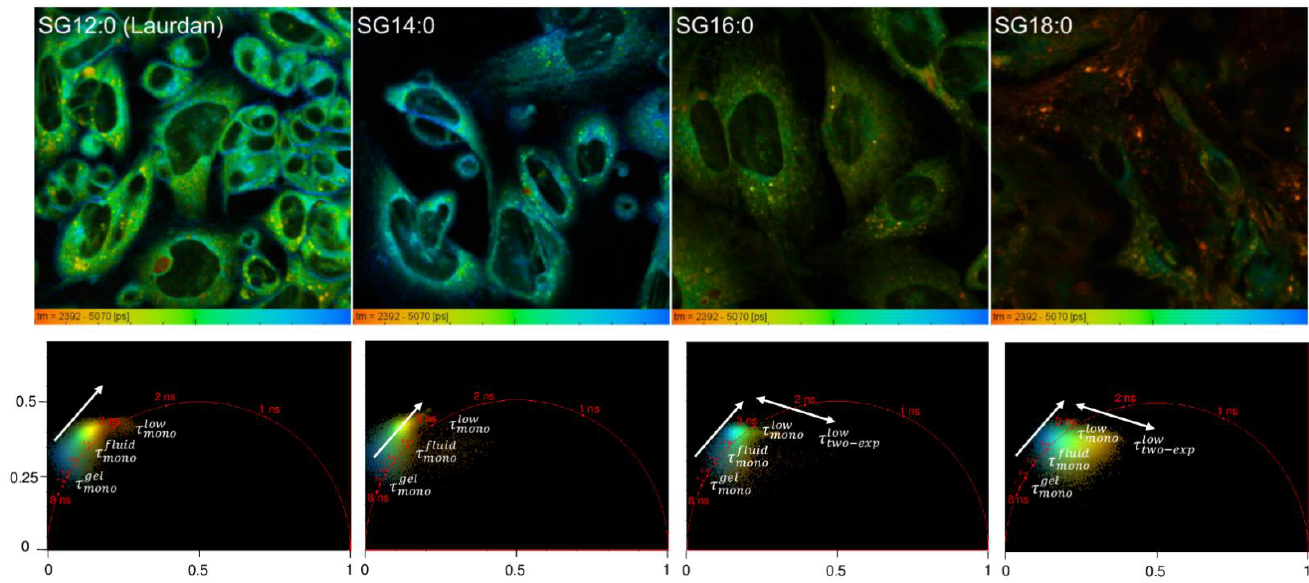
Figure 2. Whole Spectrum fluorescence imaging microscopy (FLIM) analysis of PC-12 labeled with fatty acids fluorescent derivatives. FLIM images of PC12 cells treated with laurdan (SG12:0) and the laurdan analogs (SG14:0; SG16:0; and SG18:0), integrated in the spectral range 400–600 nm, are reported. Images (first row) and phasor plot pixels (second row) are pseudo-colored in a range going from red (low lifetime 2500 ps—fluid phase) to blue (high lifetime 5000 ps—gel phase).